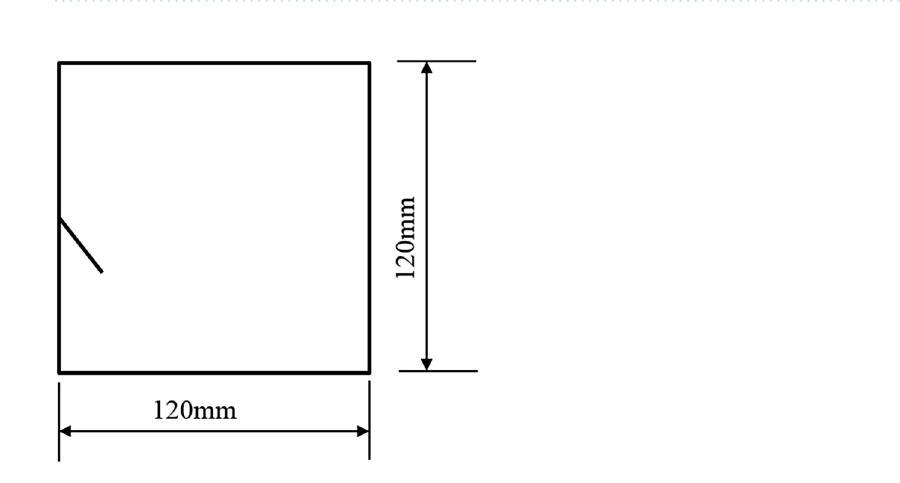
Figure 6. Precast crack orientation 3. Fissure length 2 cm, horizontal angle of fissure 40°.